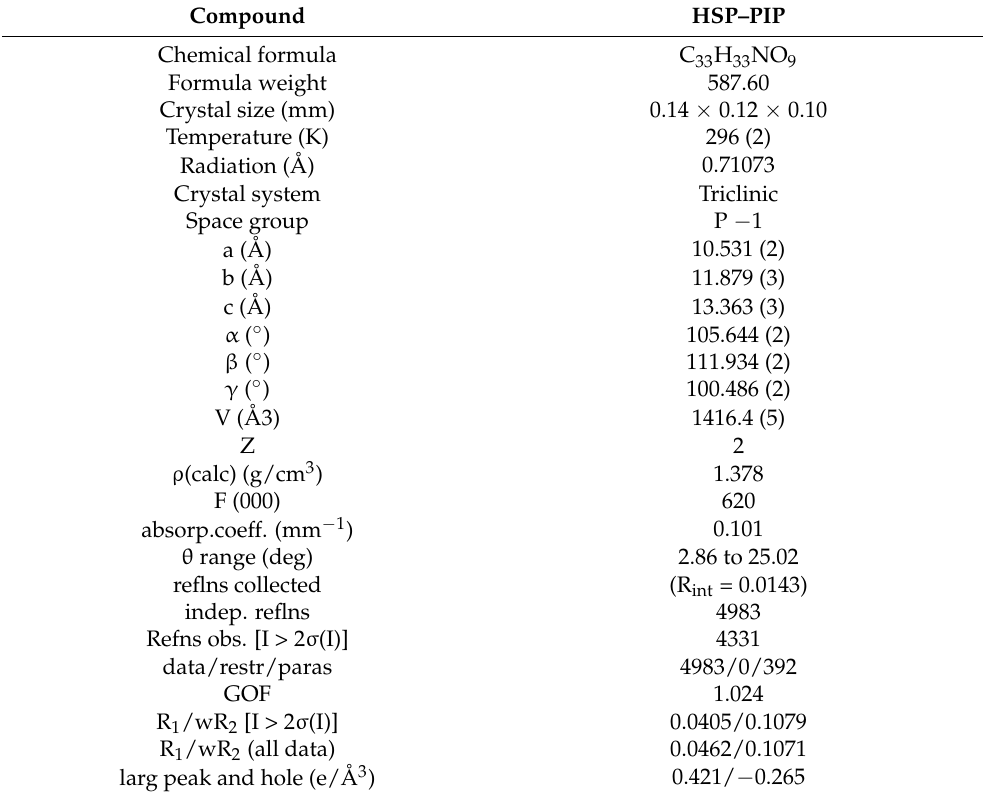
Table 1. Crystallographic Data and Structure Refinement Parameters for the HES–PIP Cocrystals.